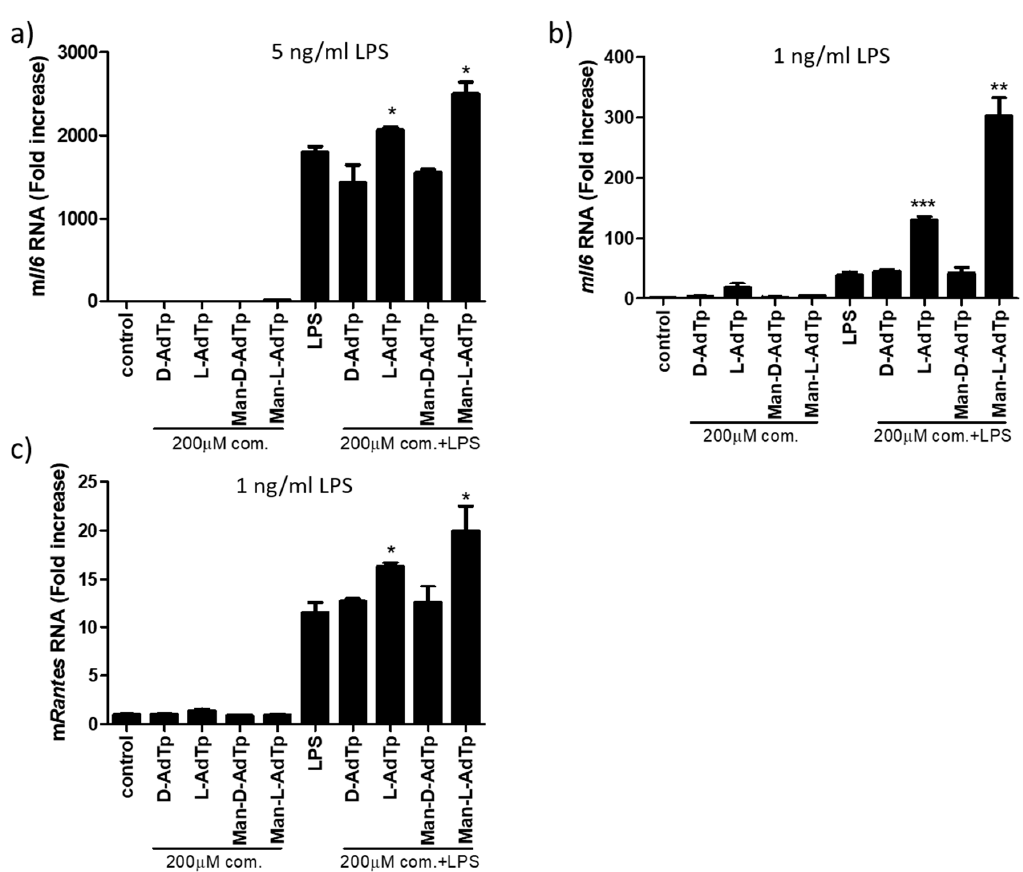
Figure 2. PGN derivates promote LPS signaling detected on the mRNA level. PGN derivatives (200 µ M) were incubated or preincubated with iBMDMs and then stimulated with LPS for 4 h; for Il6 with ( a ) 5 ng / mL LPS or ( b ) 1 ng / mL LPS and for Rantes ( c ) with 1 ng / mL LPS. RNA was isolated and qPCRs was performed. Statistics: Student’s t -Test * p < 0.05, ** p < 0.01, *** p < 0.001. As control unstimulated cells were used. Representative experiments from 3 independent experiments are shown.